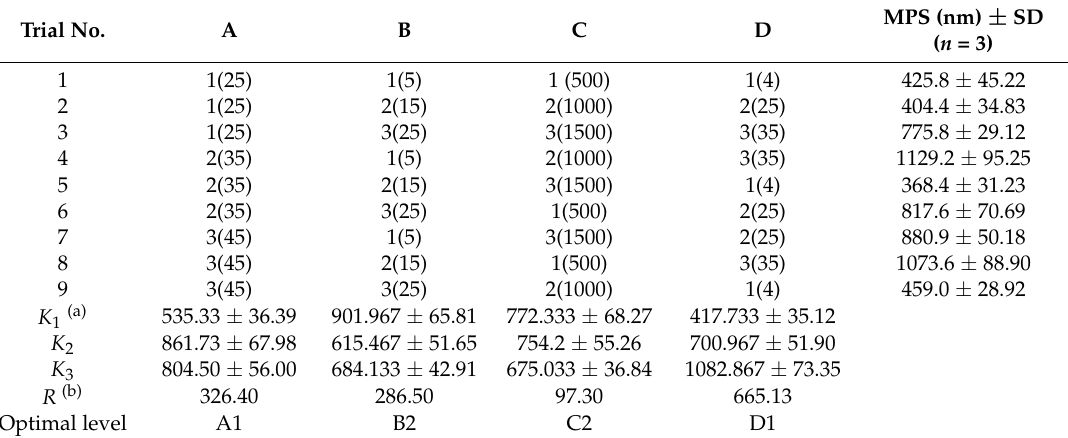
Table 1. OAD9(3 4 ) and experimental results.